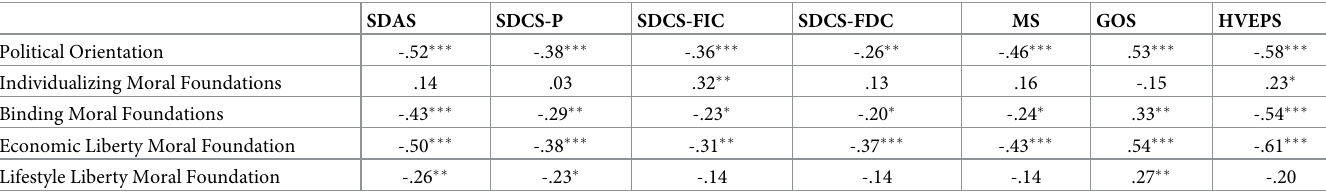
Table 7. Correlation matrix for political, moral, and social distancing outcome measures in Canadian sample (n =